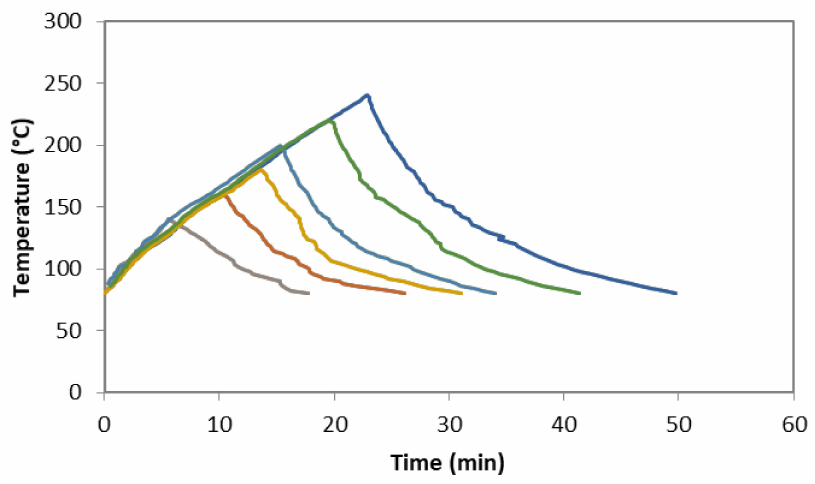
Figure 5. Heating profiles during non-isothermal treatments of Paulownia bark